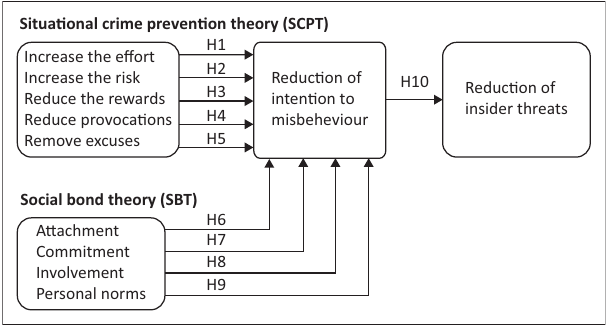
FIGURE 1: Research model on the reduction of cybersecurity insider